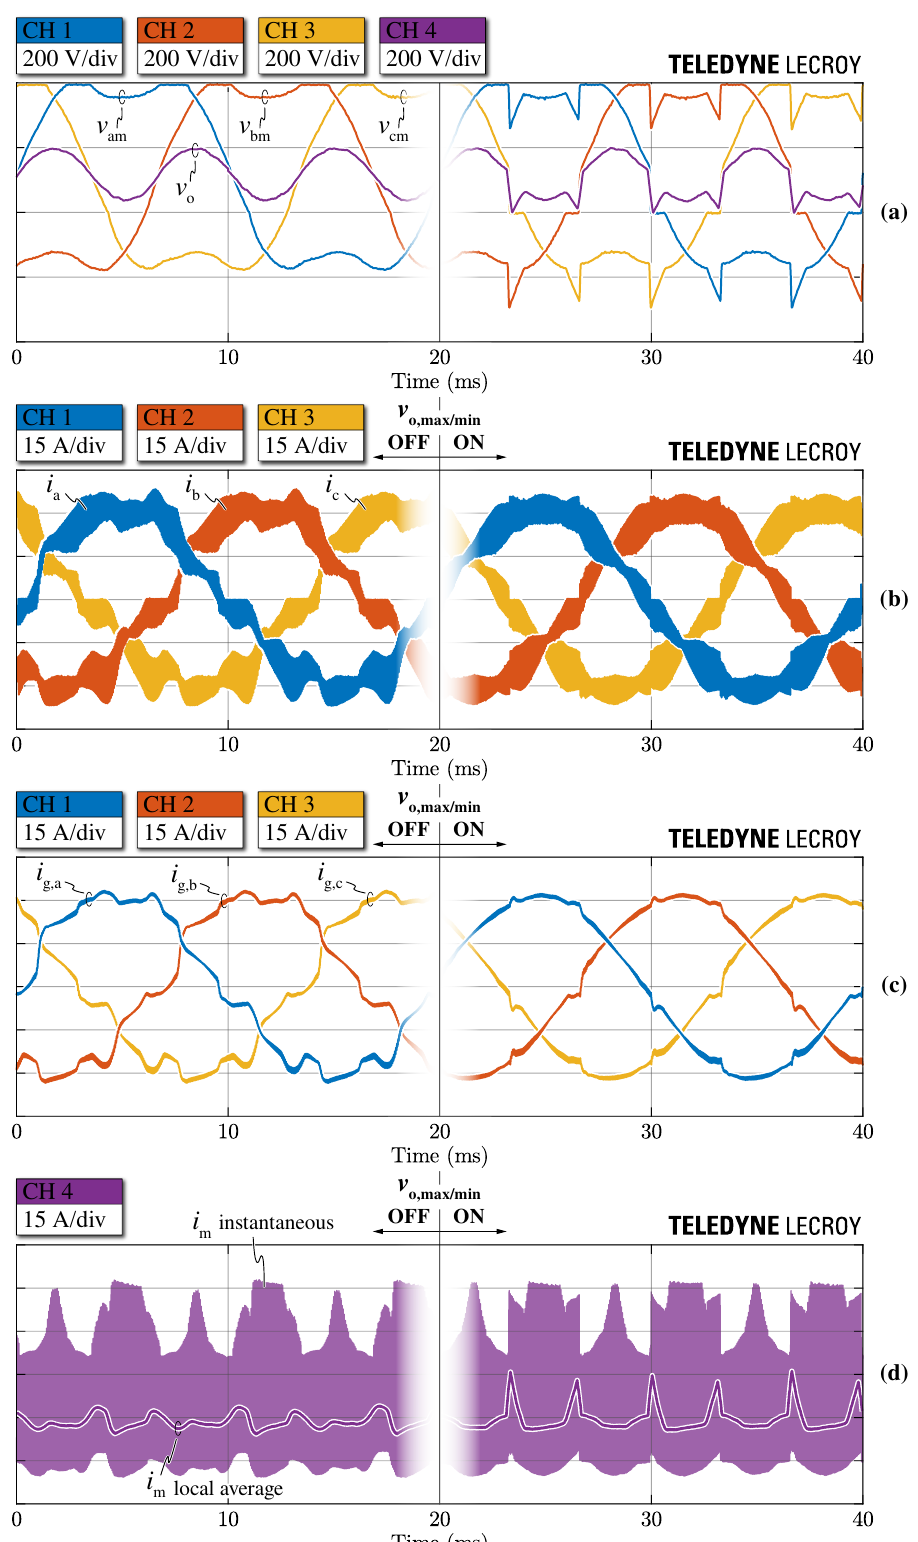
Figure 18. Experimental waveforms in steady-state conditions with V dc = 800V, ϕ = 0 and P = 15kW. A constant zero-sequence voltage component v o = 0.15 V dc / 2 is added to v o,3 (ZM- PCPWM). From top to bottom: ( a ) reference bridge-leg voltages v am , v bm , v cm and zero-sequence voltage v o (from DAC of the MCU), ( b ) converter-side currents i abc , ( c ) grid-side currents i g,abc , ( d ) and mid-point current i m , with and without the zero-sequence voltage saturation v o,max/min